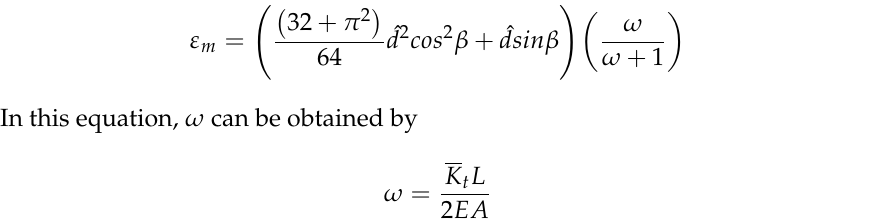
values between 𝑏𝑏